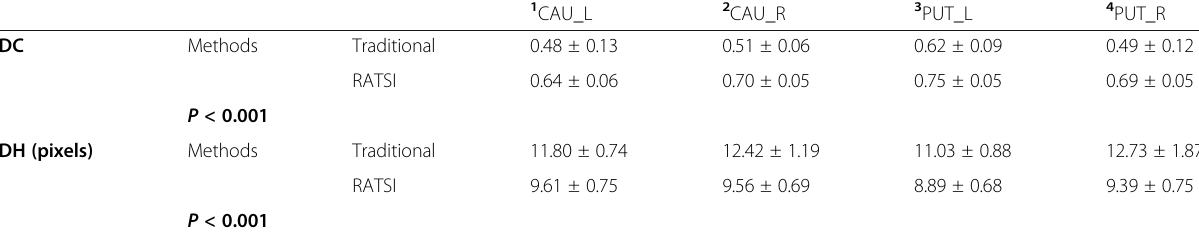
Table 1 The Dice coefficient (DC) and Hausdorff distance (HD) (mean ± SD) for evaluating the accuracy of automatic brain segmentation quantitatively